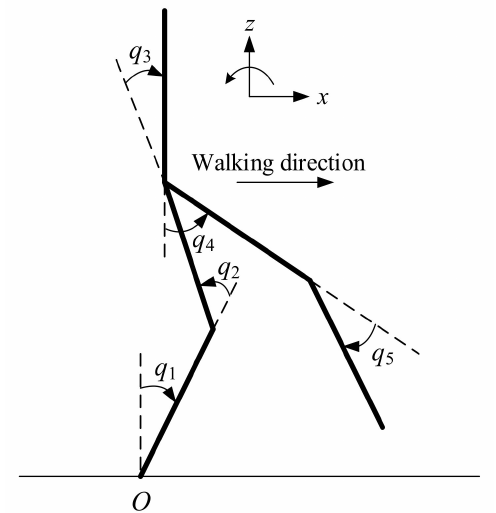
Figure 3. Generalized coordinates of the five-link biped model. The x-direction is the walking direction and the z-direction is the upright direction, angles are measured by counterclockwise